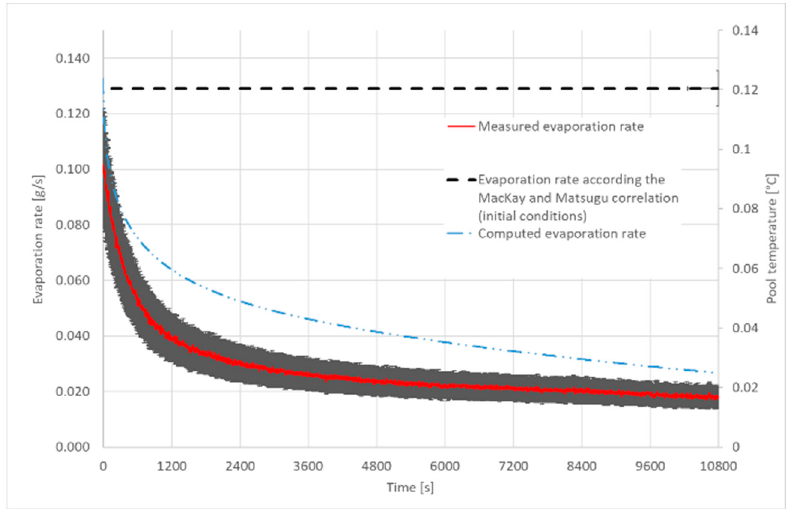
Figure 17. Time evolution of evaporation rate measured during the reference small-scale tests and calculated with the proposed model.